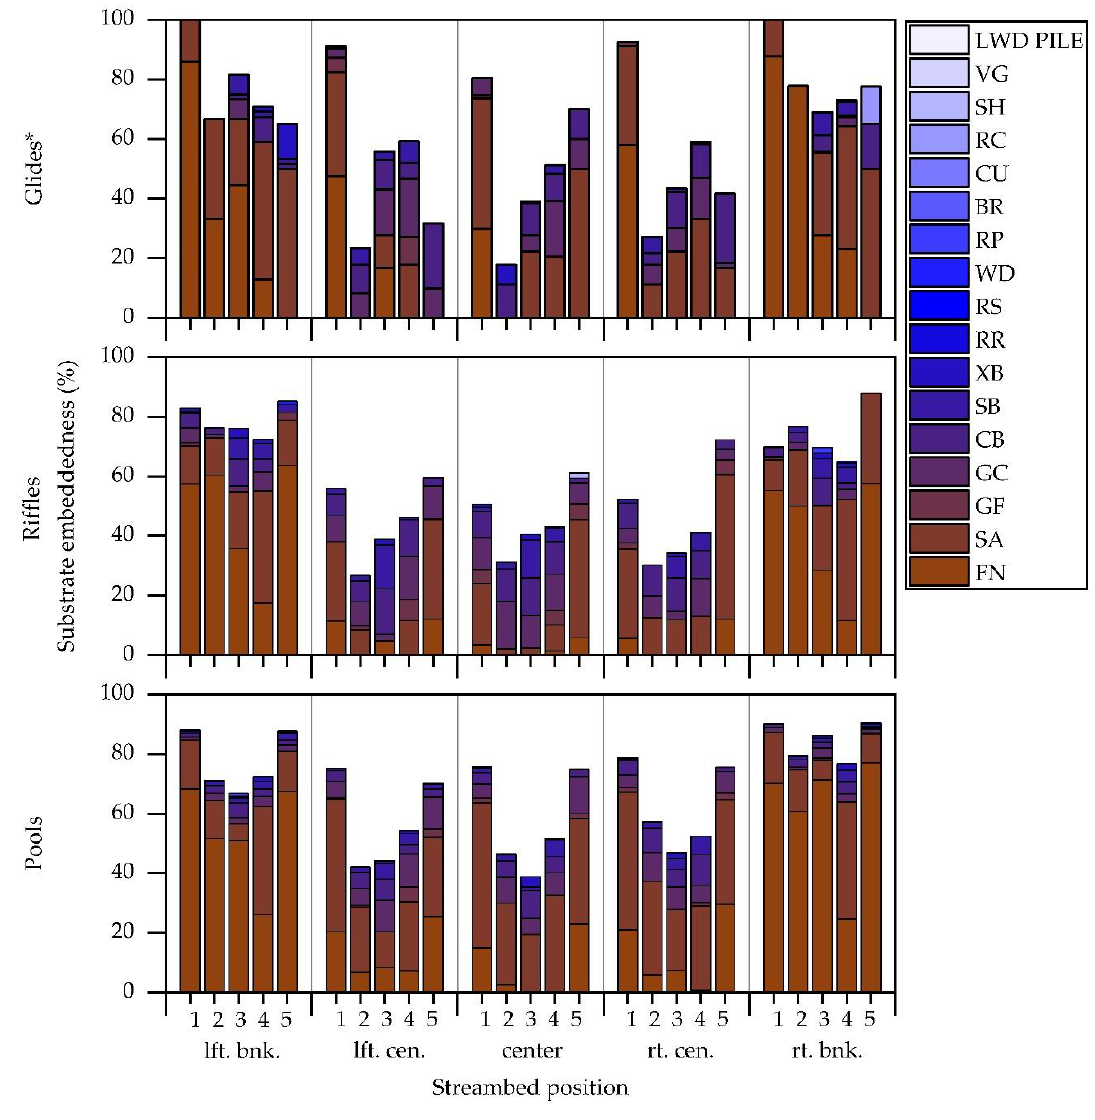
Figure 6. Substrate frequency and embeddedness from left bank (lft. bnk.) to right bank (rt. bnk.) associated with ri ffl es, glides, and pools located within five nested sub-basins (numbered 1 to 5) of Hinkson Creek Watershed, Missouri, USA. Sub-basin #1 was located in the headwaters. Sub-basin #5 was located near the watershed outlet. No glide channel units were observed at Site #1, instead, percent embeddedness of dry channel units is shown. Substrate definitions are presented in Table